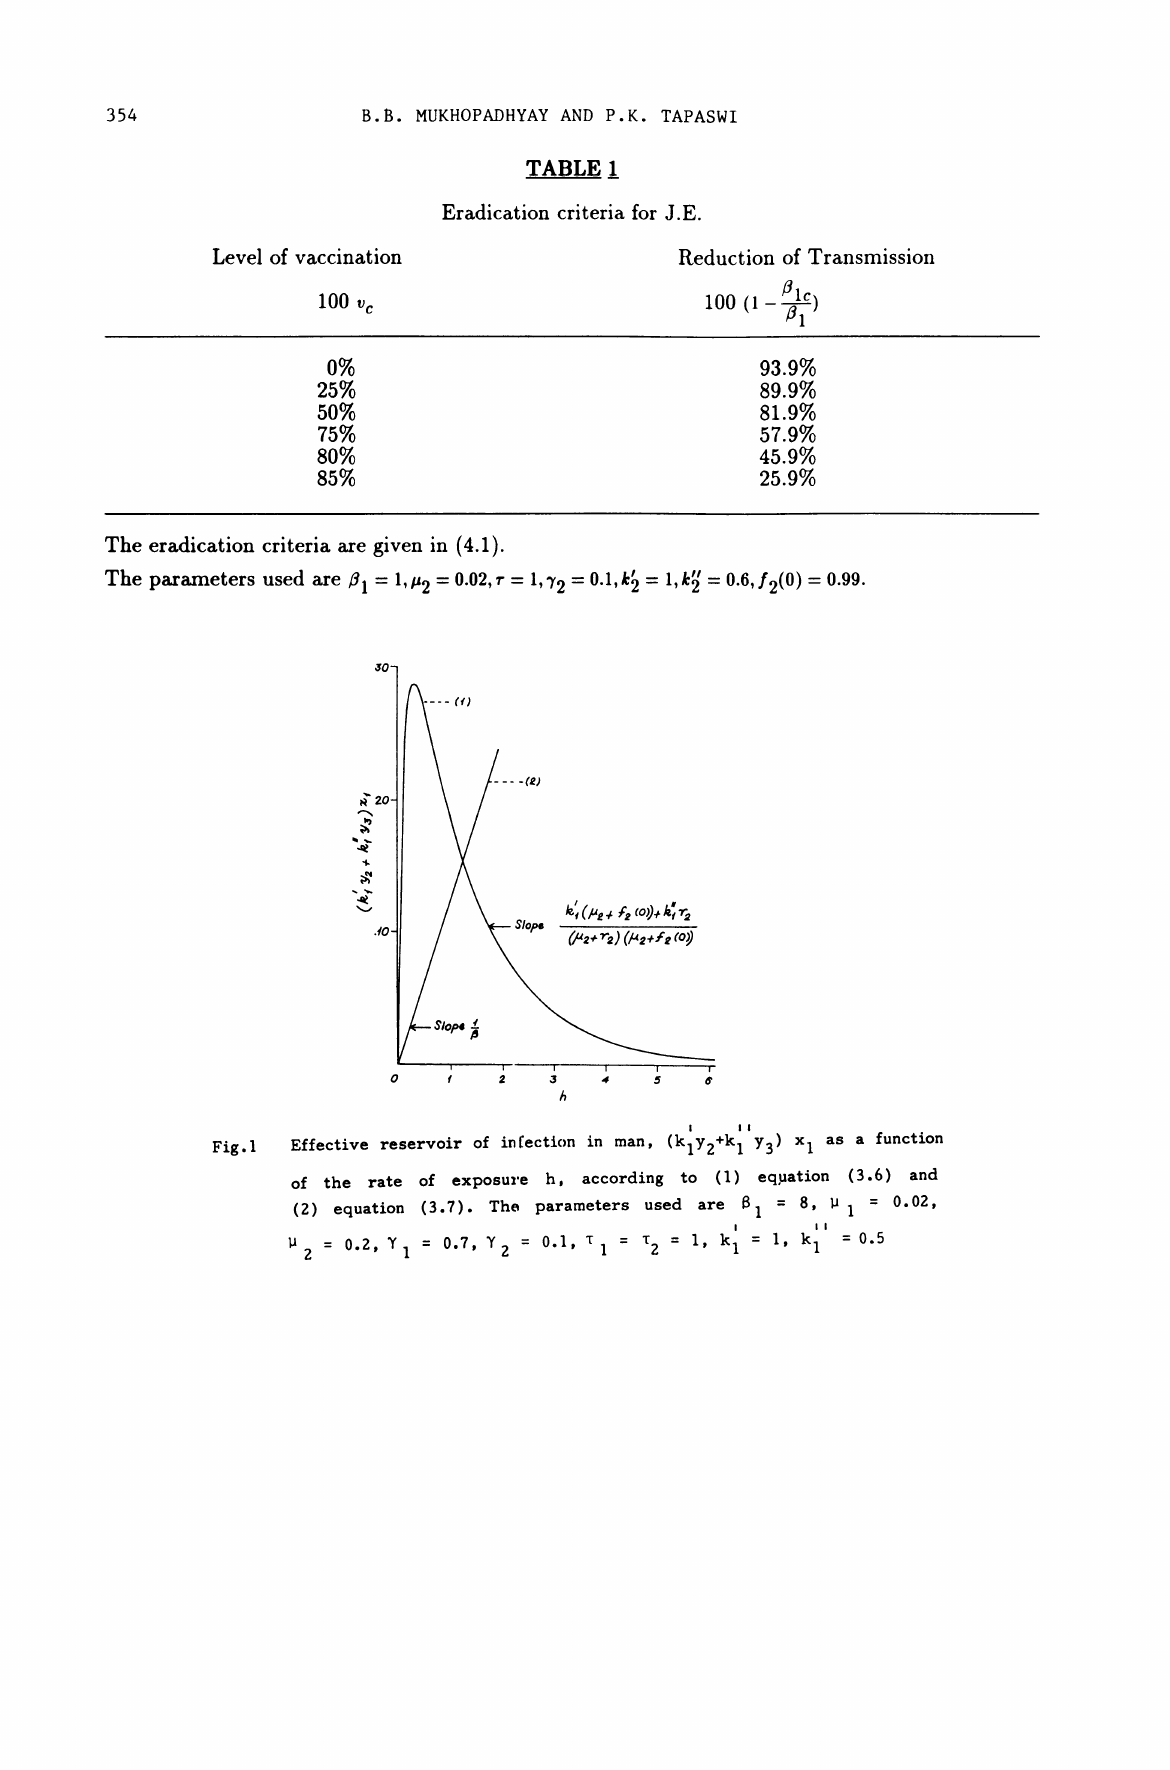
Fig. Effective reservoir of infection in man, (klY2+kl of the rate of exposure h, according to (1) eq,uation (3.6) and (2) equation (3.7). The parameters used are